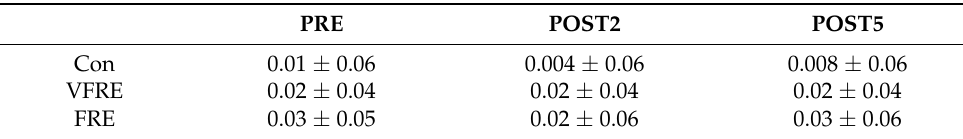
Table 5. The knee power of DJ (W/BW); mean ± SD † . PRE POST2 POST5